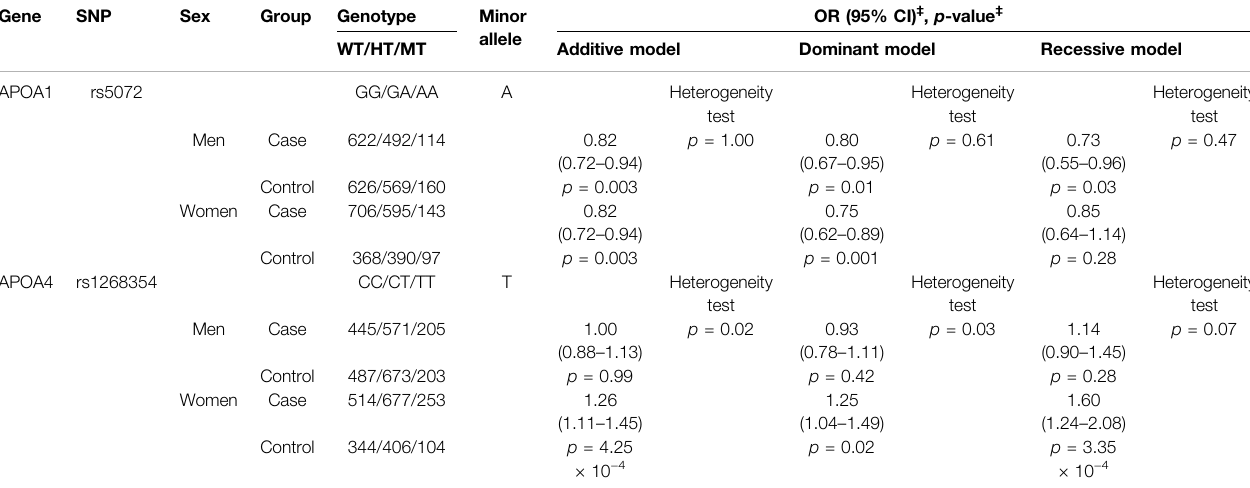
TABLE 2 | Association analysis of AOPA1 and AOPA4 with schizophrenia in men and